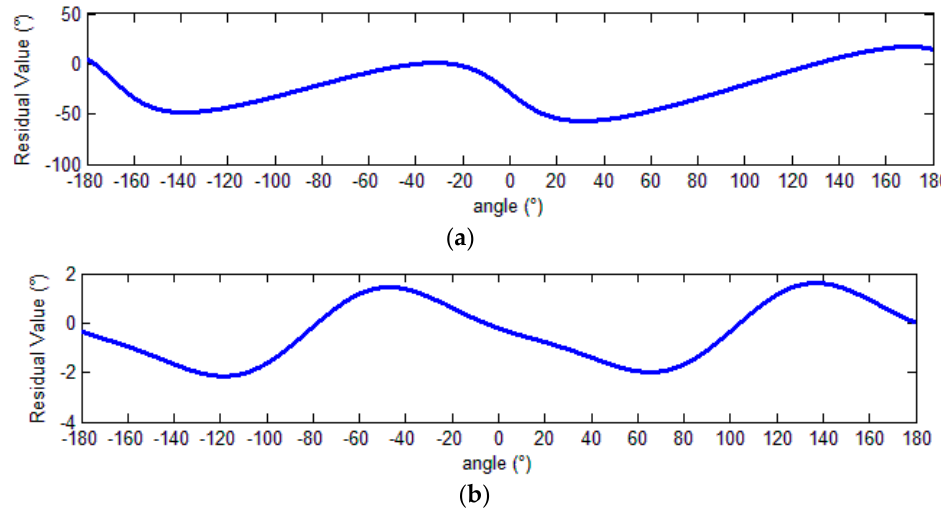
Figure 14. Demodulation errors. ( a ) Demodulation error before calibration; ( b ) demodulation error after calibration.